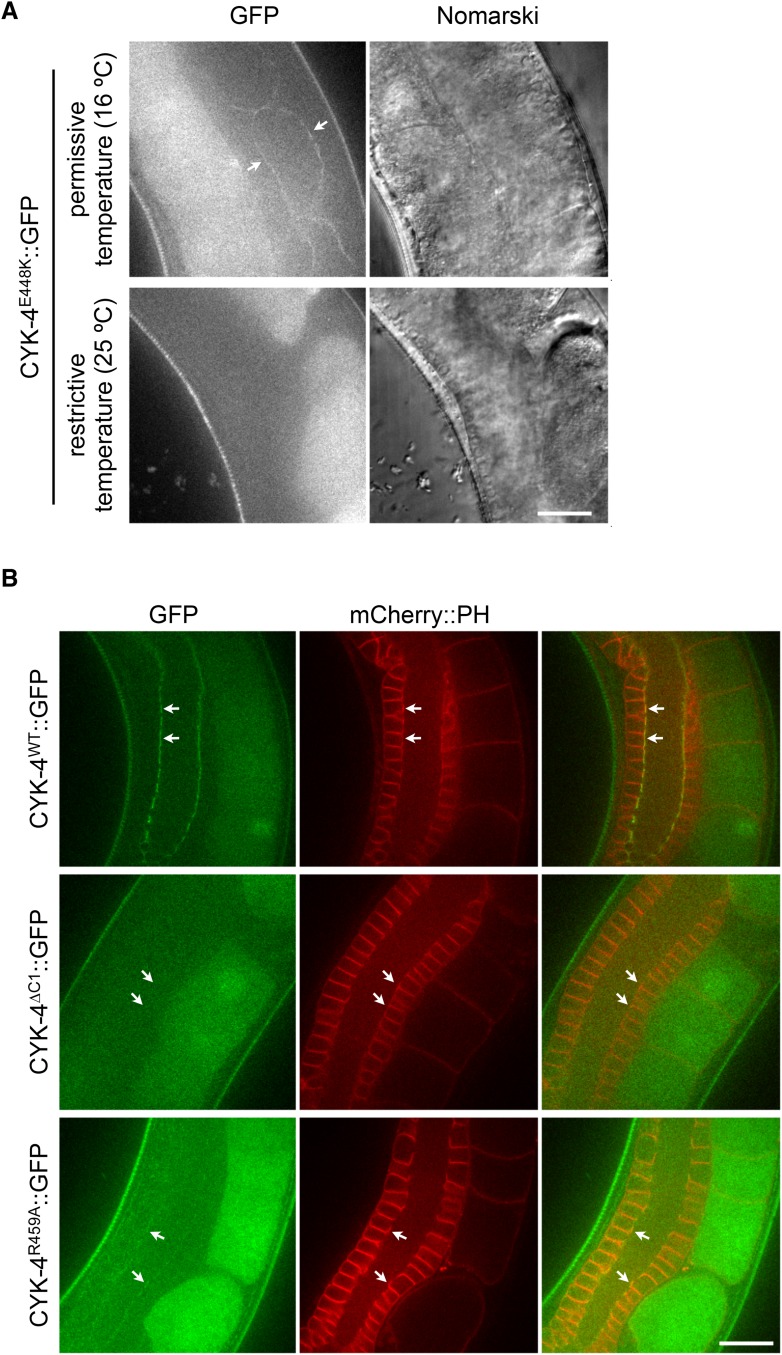
Assay for localization of CYK-4 variants to the membrane of the gonad.(A) CYK-4E448K exhibits temperature sensitive binding to the incomplete membranes of the syncytial hermaphrodite gonad. Animals in which both endogenous and the GFP-tagged transgene contain the E448K substitution were imaged either immediately after removal from a 16°C incubator or after 60 min at 25°C. At the permissive temperature, CYK-4E448K binds to the gonad membrane, but not at the restrictive temperature. (B) The localization of CYK-4WT, CYK-4∆C1, and CYK-4R459A was analyzed in hermaphrodite gonads. mCherry::PH was used to mark the membranes in the syncytial gonad. Whereas both CYK-4WT and CYK-4R459A label the membranes in the syncytial gonad, CYK-4∆C1 does not.